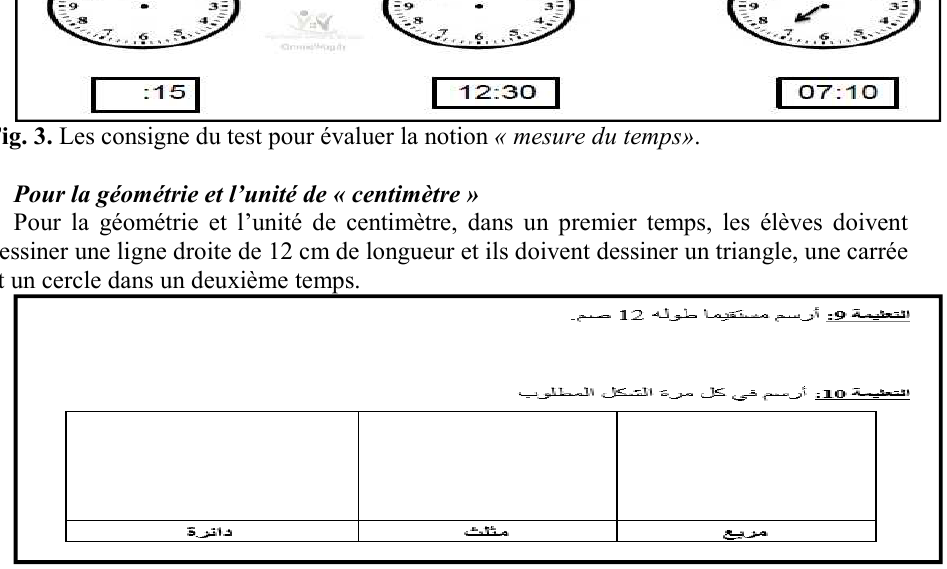
Fig. 4. Les consigne du test pour évaluer la notion « géométrie et l’unité de centimètre»